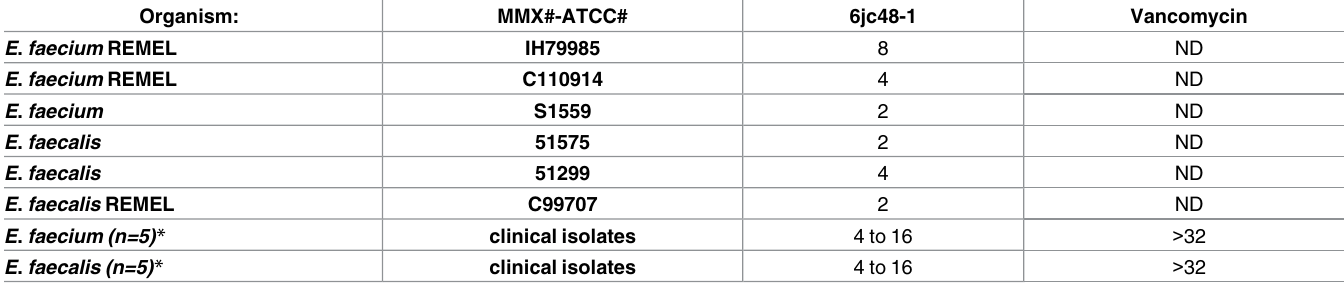
Table 2. Activity of 6jc48-1 against Enterococcus spp